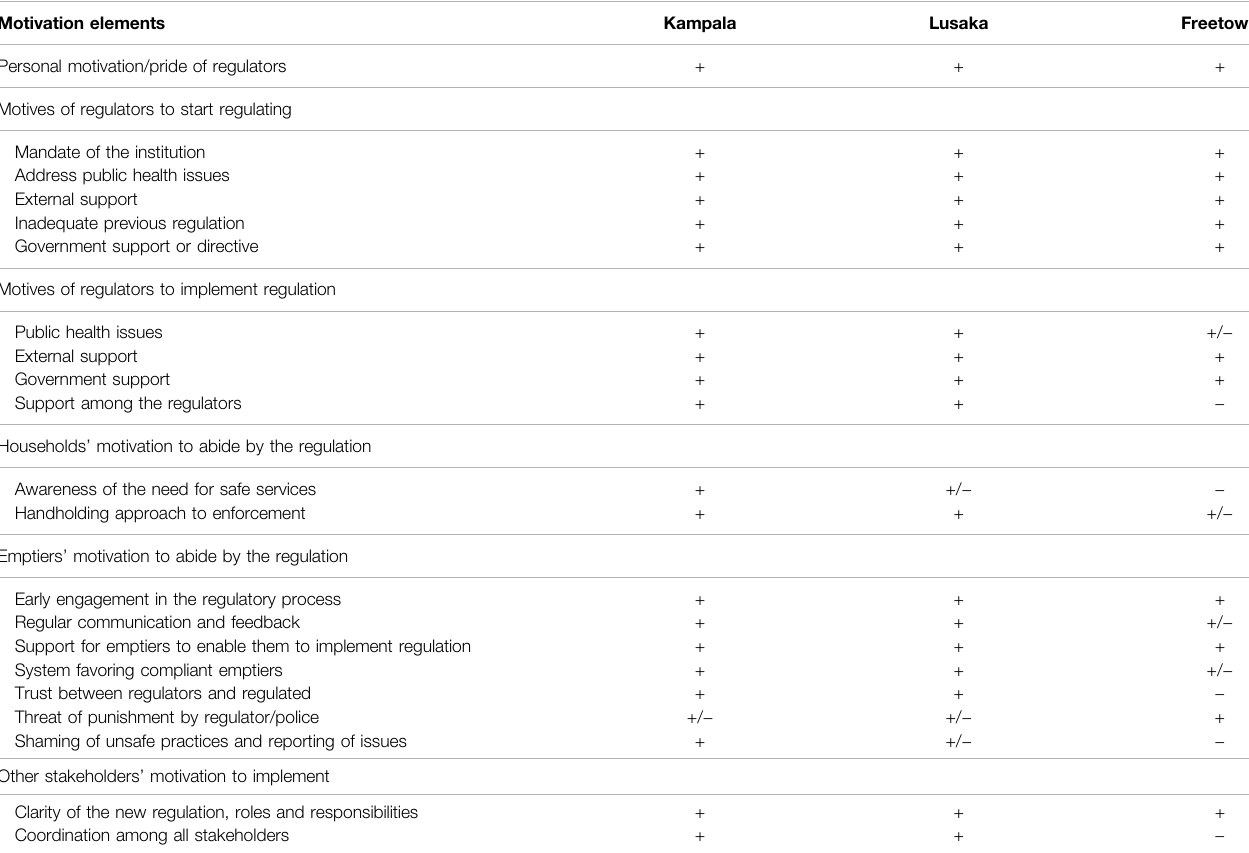
TABLE 5 | Barriers to and enablers for motivation from